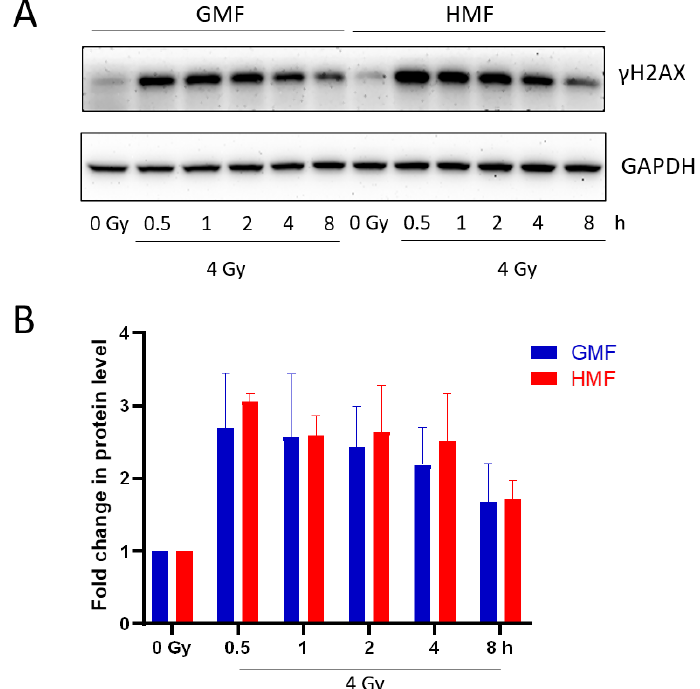
Figure 5. Western blot immunoreactivity of γ H2AX. ( A ) Whole cell extracts were prepared at 0, 0.5, 1, 2, 4, and 8 h after 2 Gy exposure. Western blotting was performed with specific antibody. GAPDH as a loading control; ( B ) histograms showing the relative levels of γ H2AX in ( A ) experiments. The ratio of γ H2AX to Actin at 0 Gy is normalized to “1”. Data represent mean ± SEM ( n = 3). Data were analyzed using one-way ANOVA.